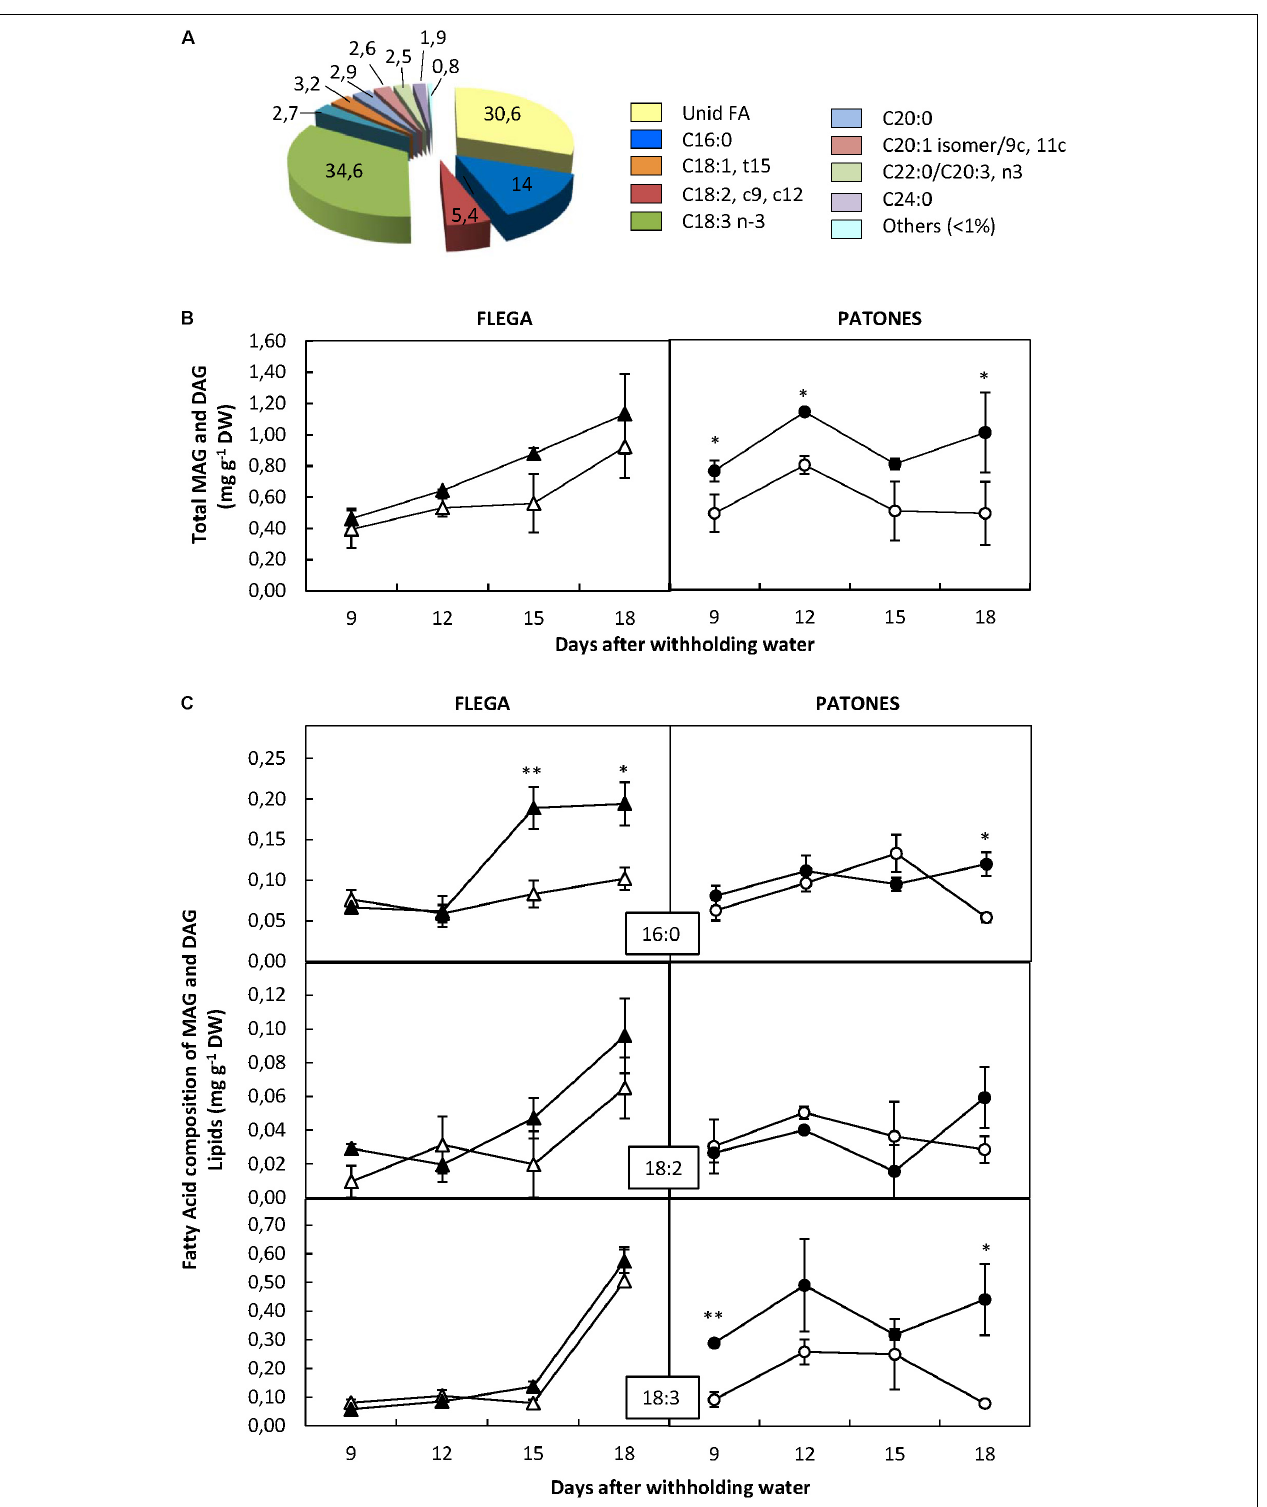
FIGURE 4 | Fatty acid content of mono- and di-acylgliceride fraction. (A) Fatty acid distribution within mono- and di-acylgliceride fraction. The proportion of fatty acids detected in the fraction was calculated from a profiling of 92 fatty acids. (B) Fatty acid content. (C) Fatty acids accounting for at least 5% of the fraction were quantified in drought susceptible Flega (triangles) and resistant Patones (circles) well-watered plants (open symbols) and during a time course of water stress (solid symbols) (9, 12, 15, and 18 days). Data are mean of five replicates ± standard error. ∗ and ∗∗ indicate significant differences at P < 0.05 and 0.01, respectively.